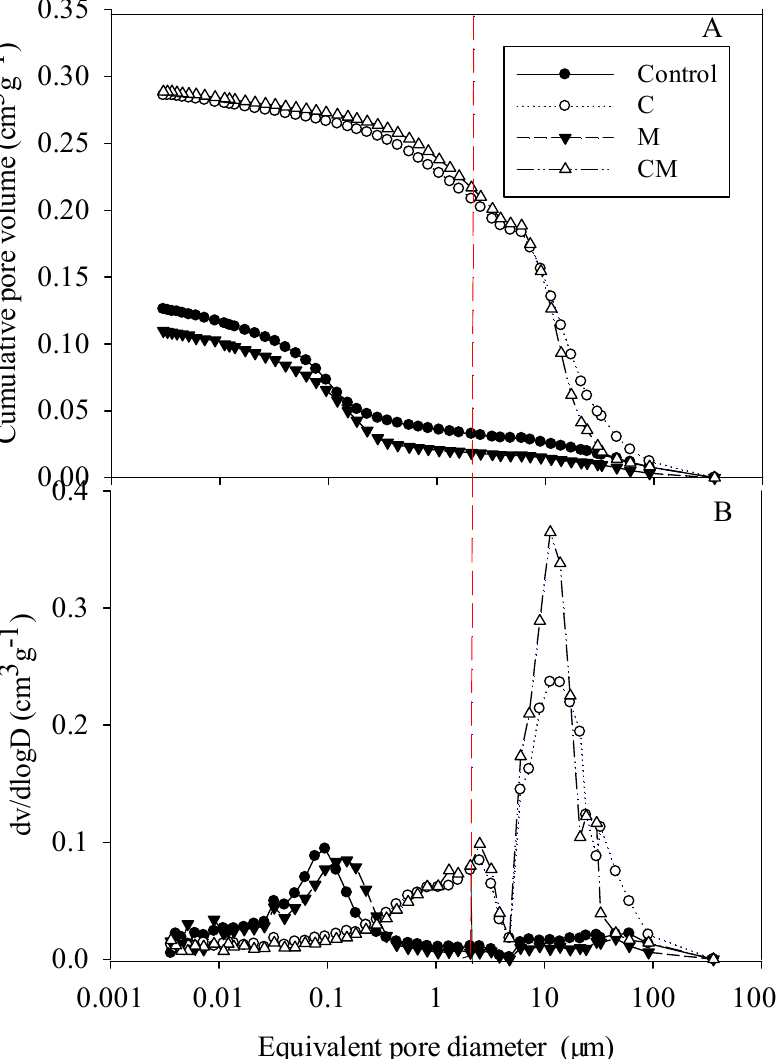
Figure 2. Cumulative ( A ) and differential ( B ) pore size distribution of different treatments deter- by MIP in the range of 0.001–1000 µ m. The red vertical line is the dividing line (2 µ m) between the mined by MIP in the range of 0.001–1000 μ m. The red vertical line is the dividing line (2 μ m) be- ineffective and effective tween the ineffective and effective pores.